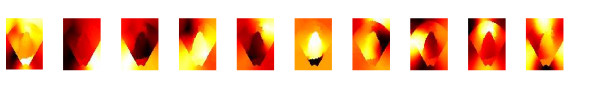
All Obtained Eigenvectors.